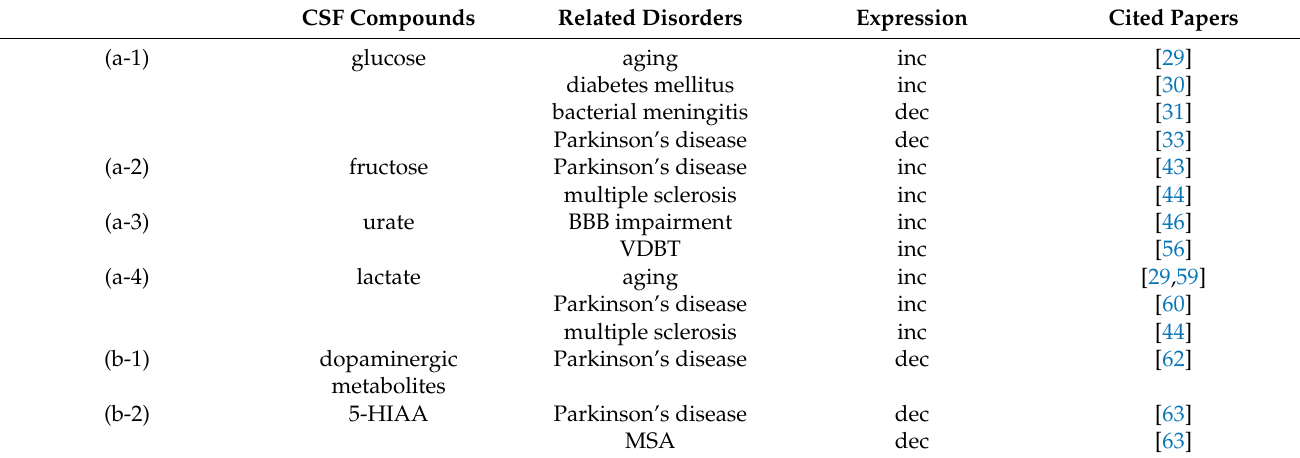
Table 3. Glucose- and neurotransmitter-related CSF metabolites of